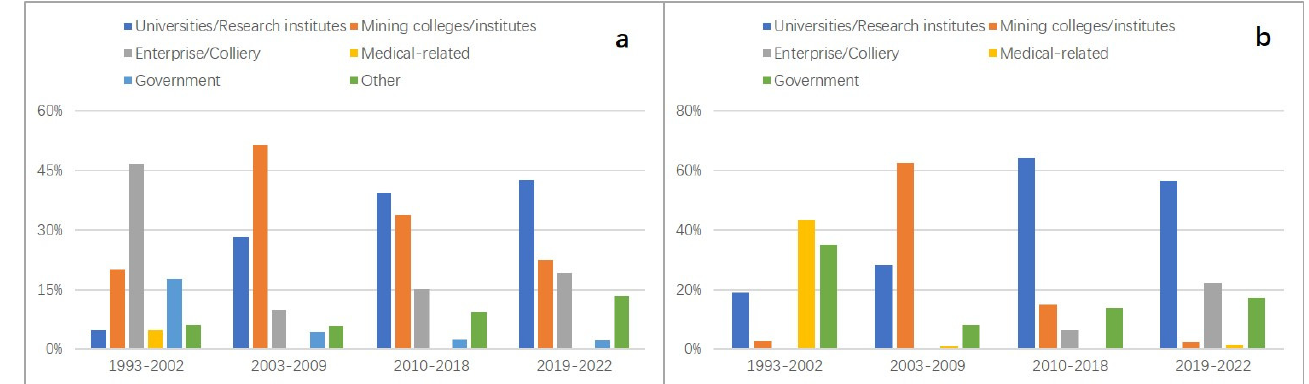
Figure 7. Distribution of new authors by institution ( a ) for studies in Chinese; ( b ) for studies in English).